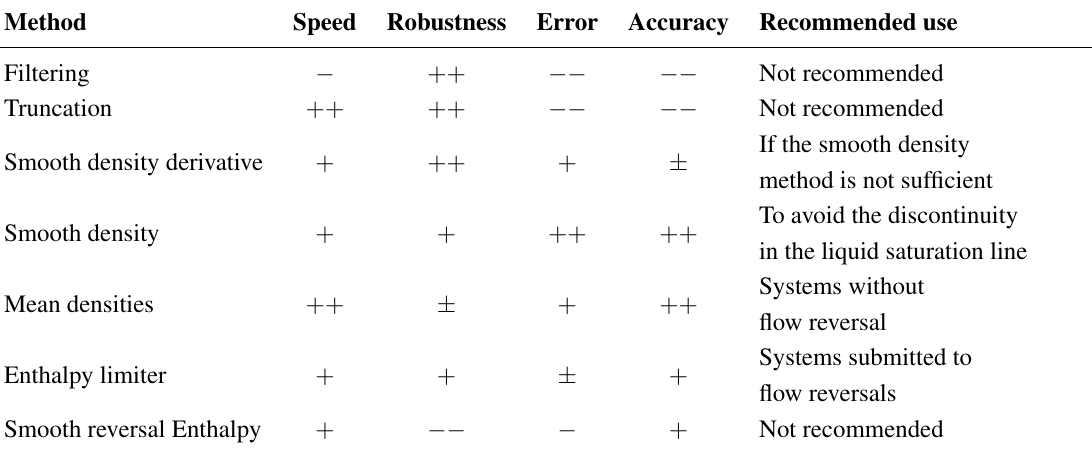
Table 5. Summary of the different